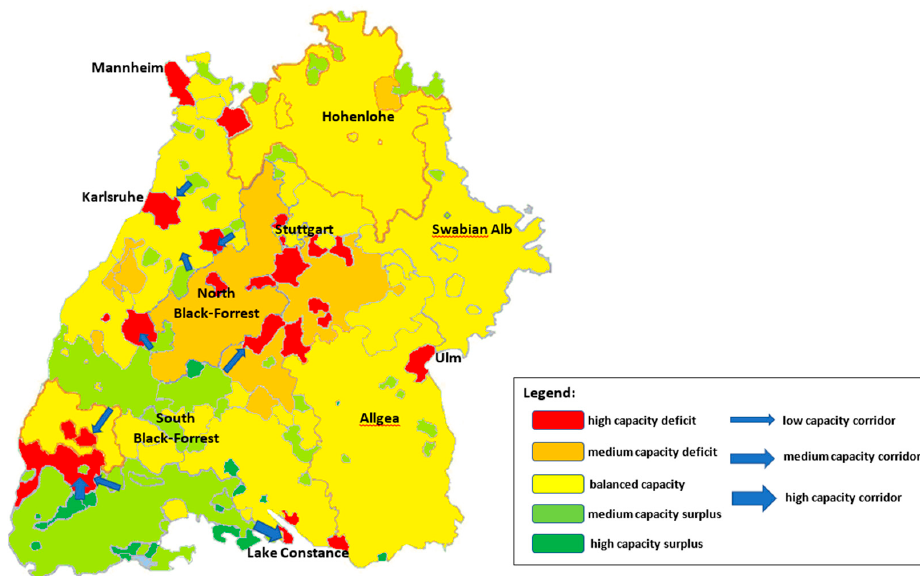
Figure 7. Scenario 2050 for growing consumption and decreasing regenerative energy supply.